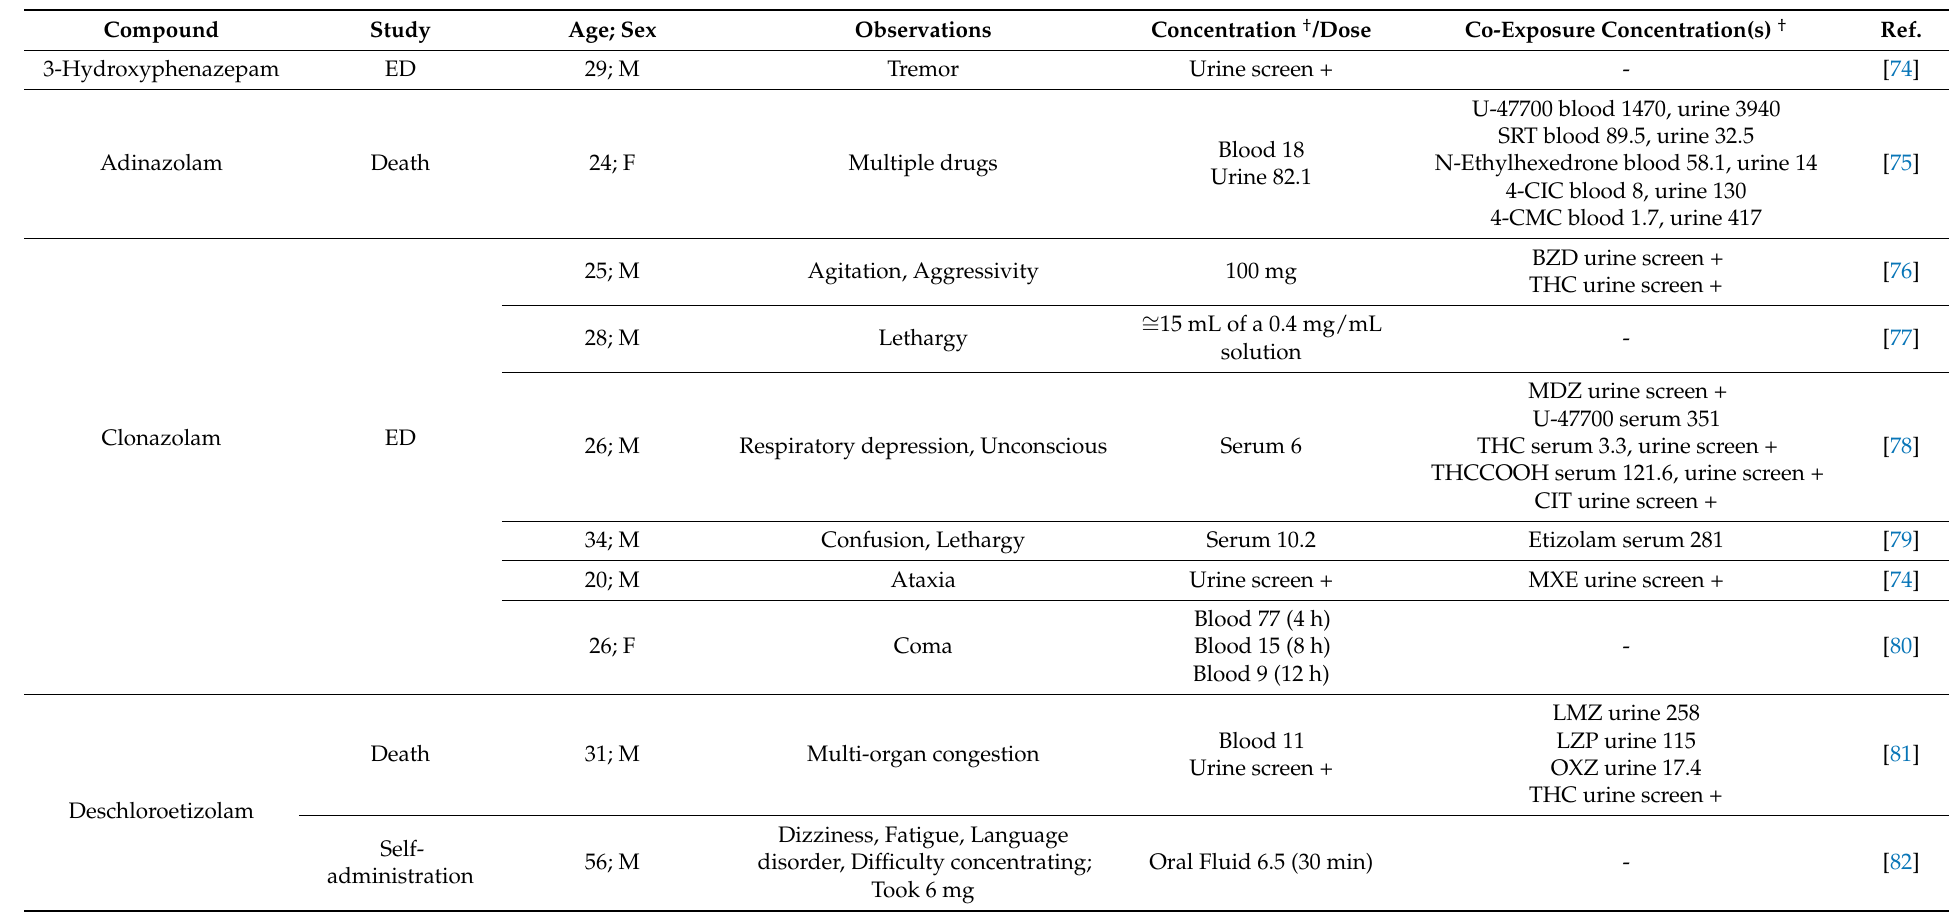
Table 1. Designer benzodiazepine (DBZD) case